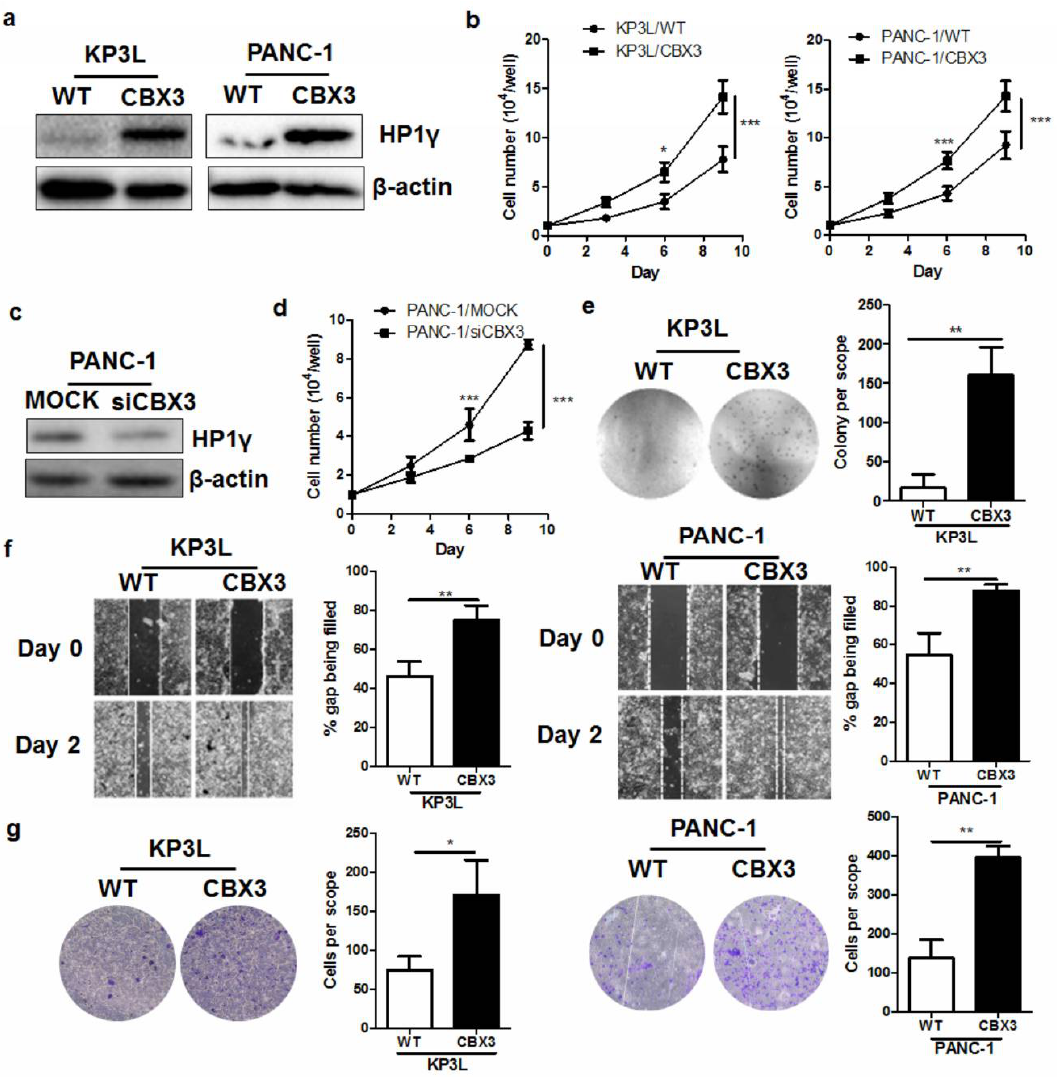
Figure 2. CBX3 overexpression increased in vitro proliferation and invasion of PAAD cells. ( a